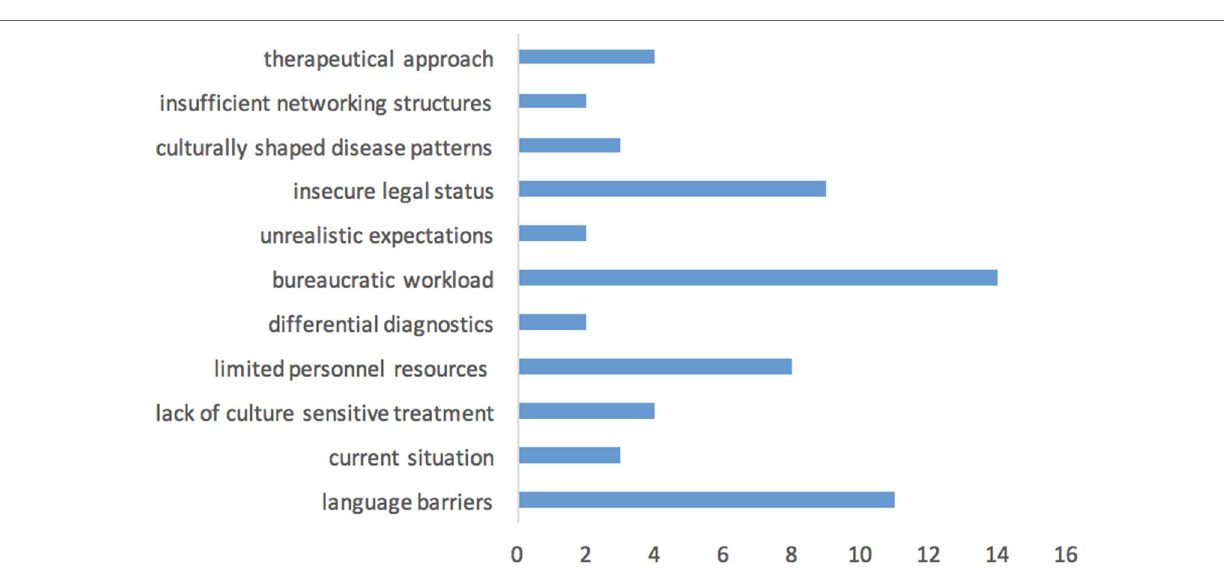
FIGURE 4 | Impediments to high quality of mental health care for refugees and the number of namings ( N = 14